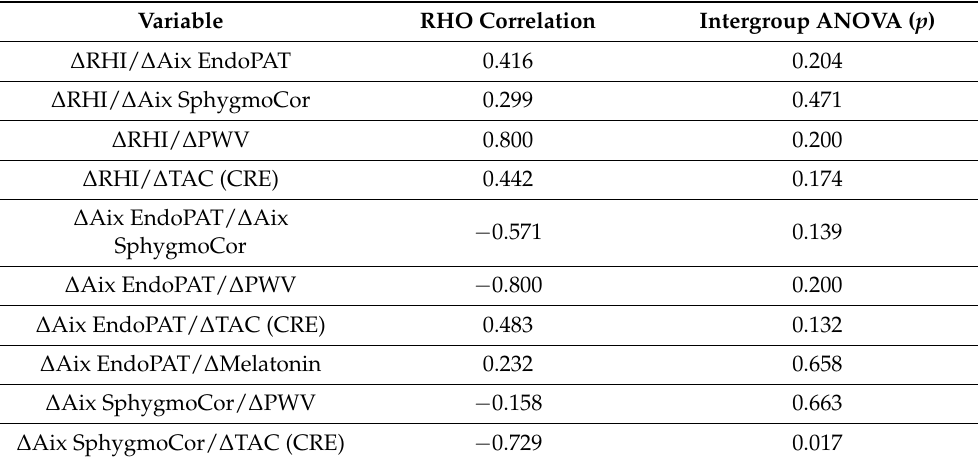
Table 6. Non-parametric correlation between vascular indexes and oxidative markers. Data are expressed as mean ± standard deviation